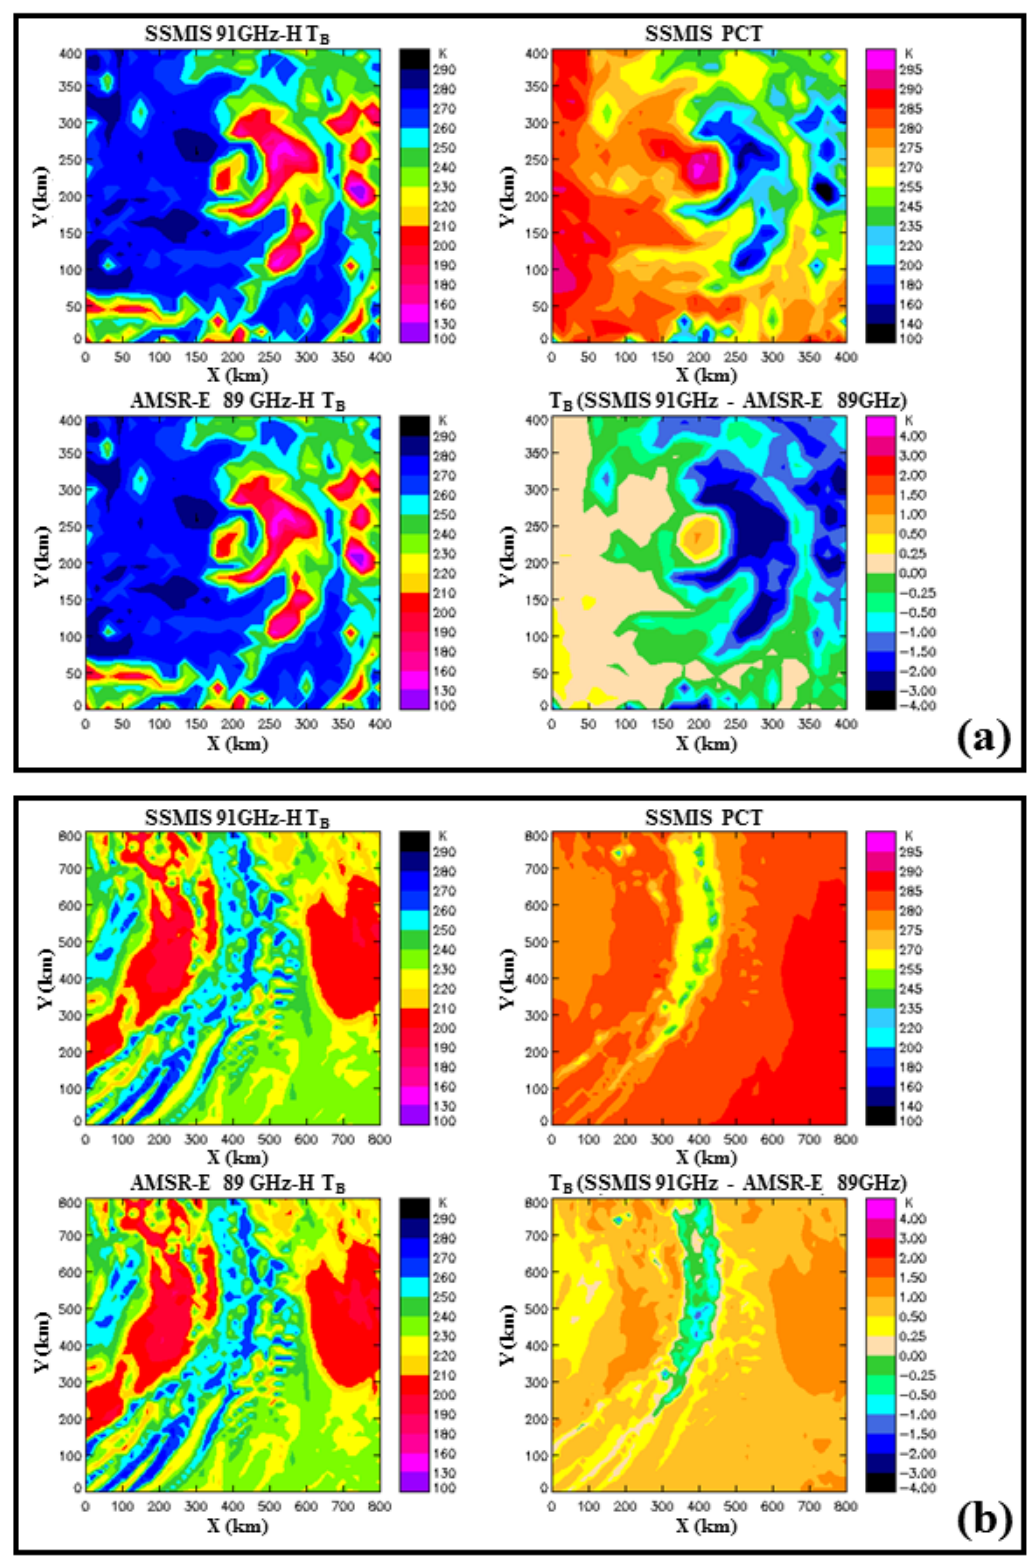
Figure 5. Same as Figure 4, except for SSMIS 91 GHz-H pol and AMSR-E 89 GHz-H